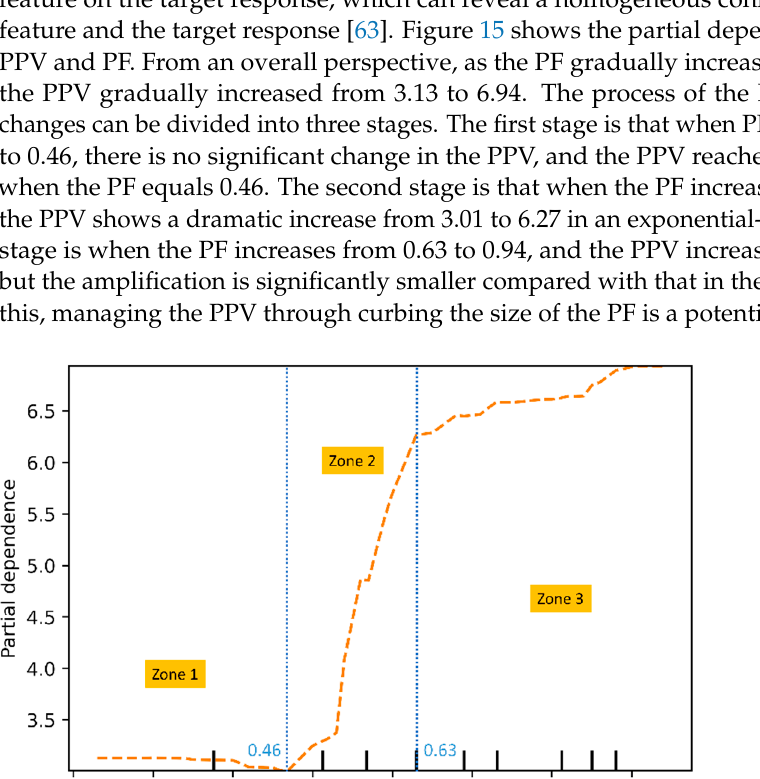
Figure 14. Significant correlation of the input variables with PPV.